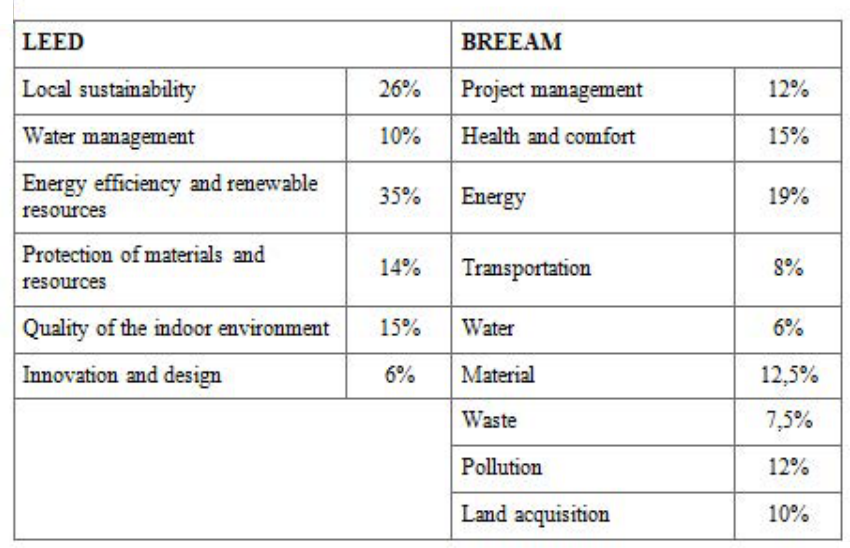
Table 1. Comparison of categories and weights of certification systems LEED vs